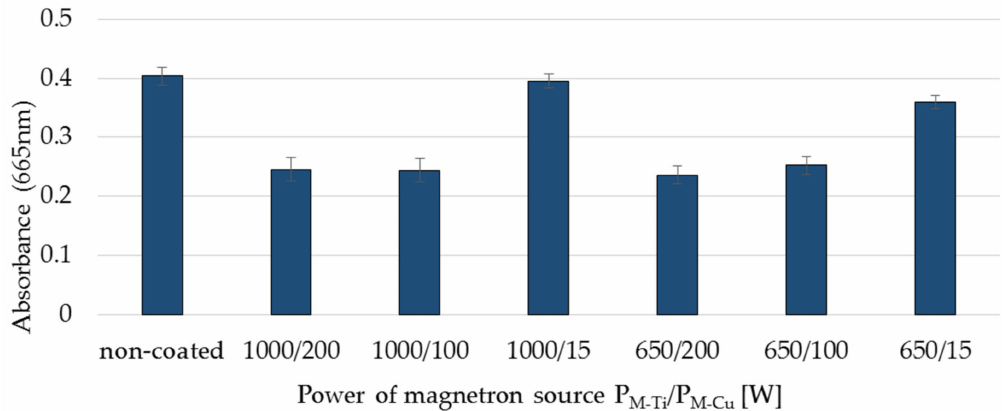
Figure 8. Comparison of the absorbance after exposure of the coatings to daylight for 24 h for non-coated membrane and membranes covered with TiO 2 + CuO coatings deposited within 30 s at different magnetron power (P M-Ti /P M-Cu ).